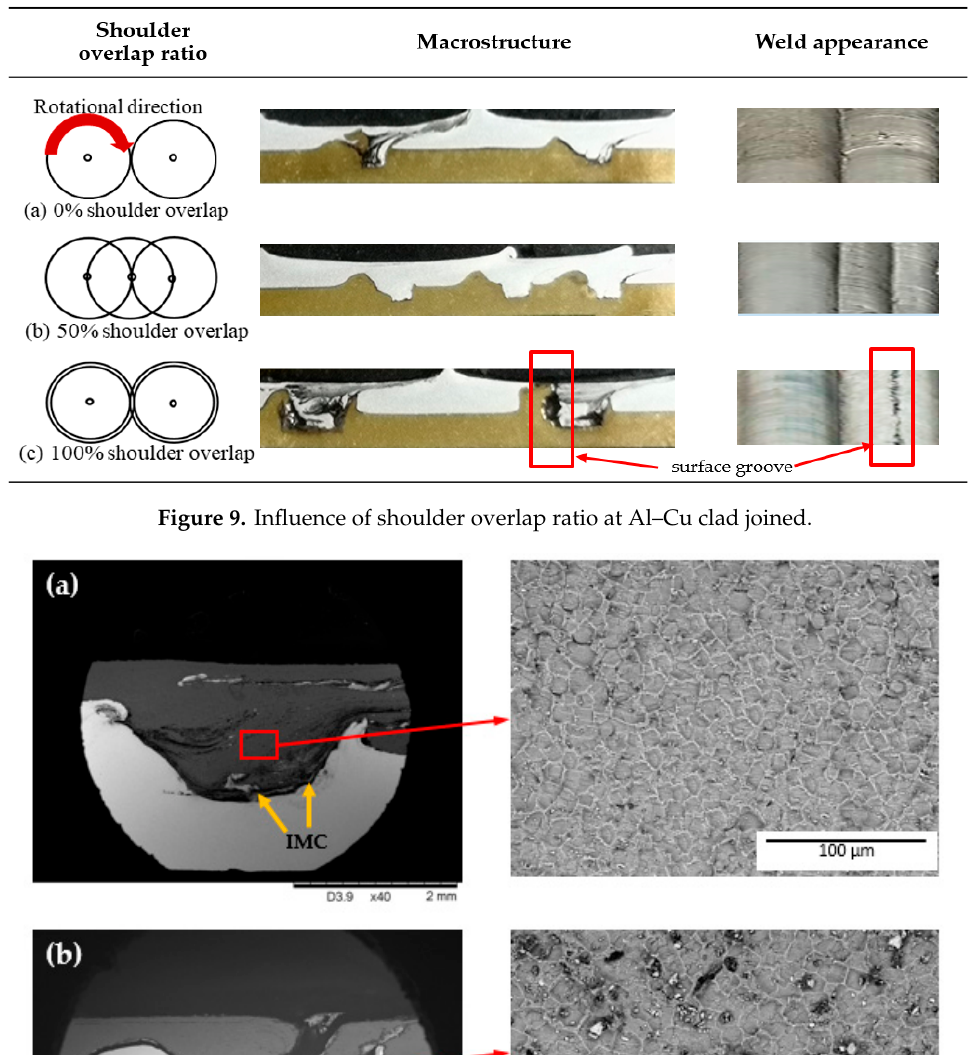
Figure 9. Influence of shoulder overlap ratio at Al–Cu clad joined.